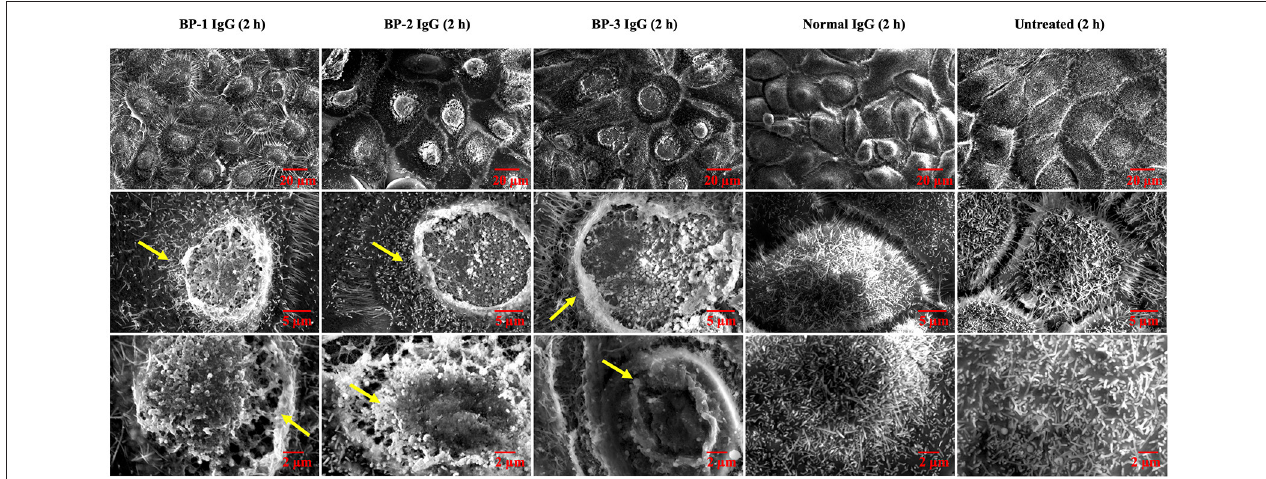
FIGURE 4 | SEM images of NHEKs stimulated with BP IgG. SEM images of NHEKs treated with BP IgGs (BP-1, BP-2, and BP-3) or normal IgG for 2h. The lower magnification pictures show the connections of cells and filopodia. The higher magnification pictures show the cell surface and microvilli of individual cells. The alterations in the cell membrane structure are indicated with